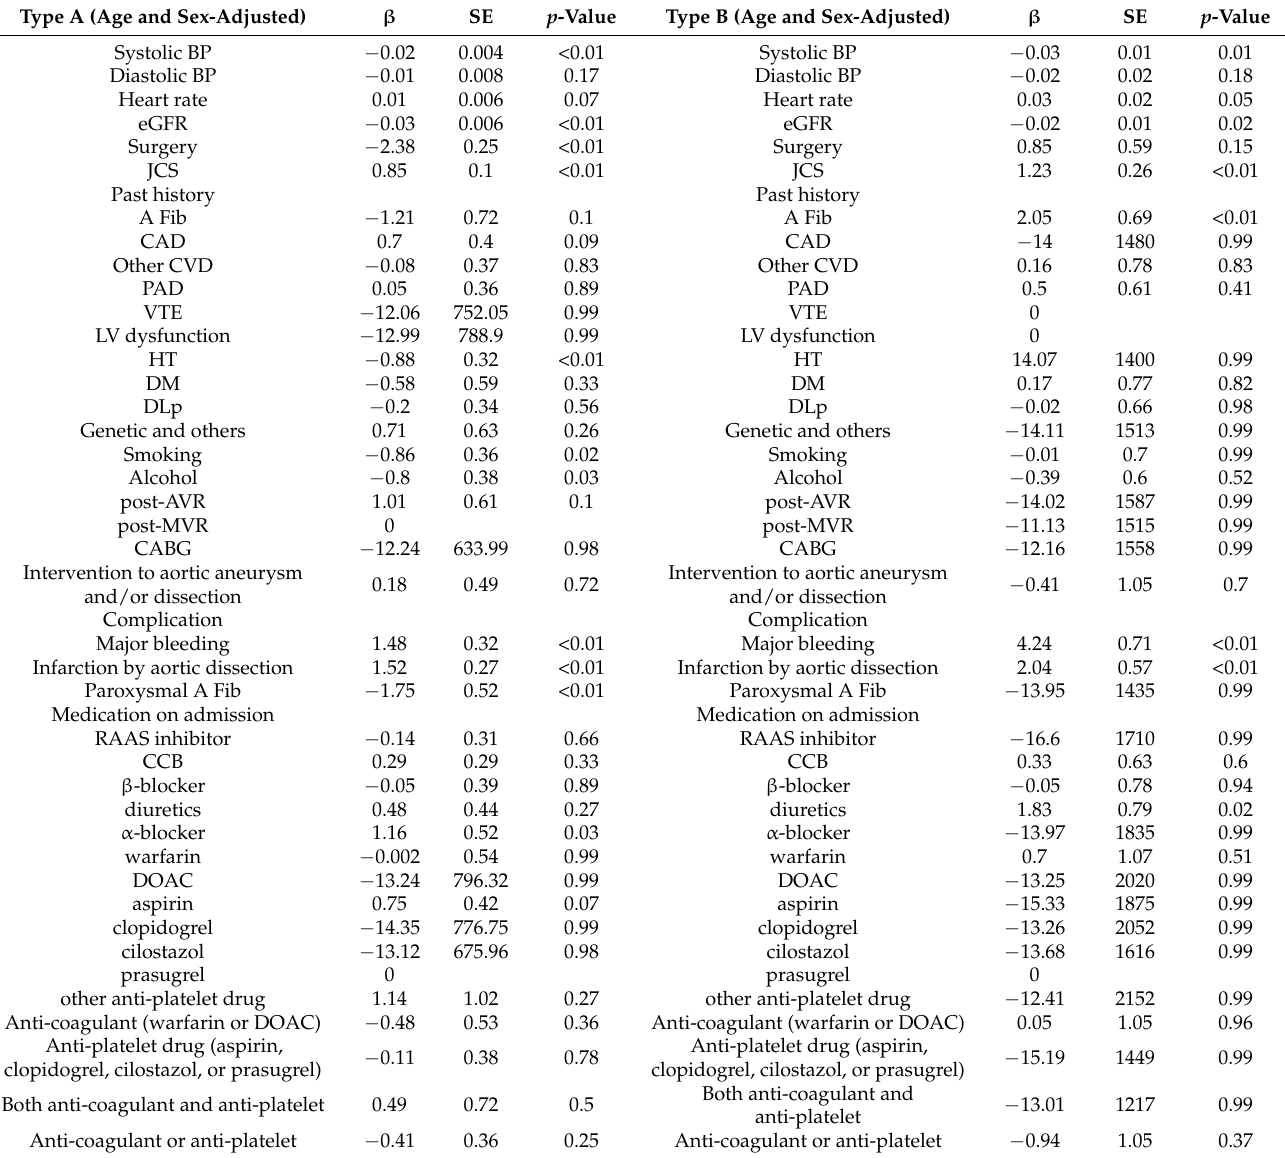
Table 5. Age and sex-adjusted Cox proportional hazard model for all-cause mortality in TRANS- FERRED acute aortic dissection